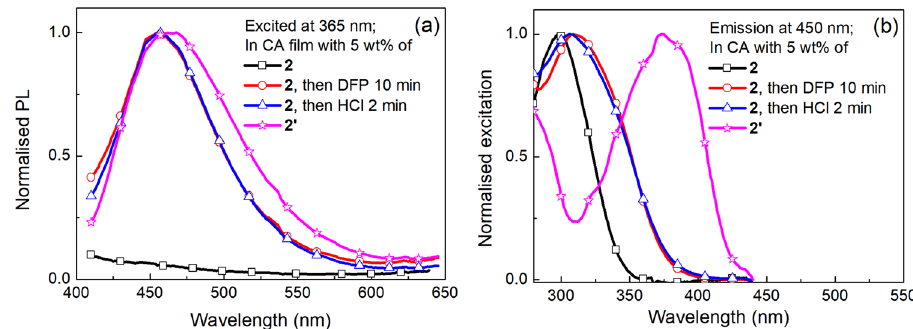
Fig. 9 The optical properties of 2 and 2 ’ :cellulose acetate fi lms compared to 2:cellulose acetate fi lms upon exposure to aged DFP or hydrogen chloride vapor. a PL emission and b excitation spectra. PL spectra were recorded using an FS5 spectrometer. DFP and HCl vapor were generated using the setup described in Supplementary Fig. S2a.